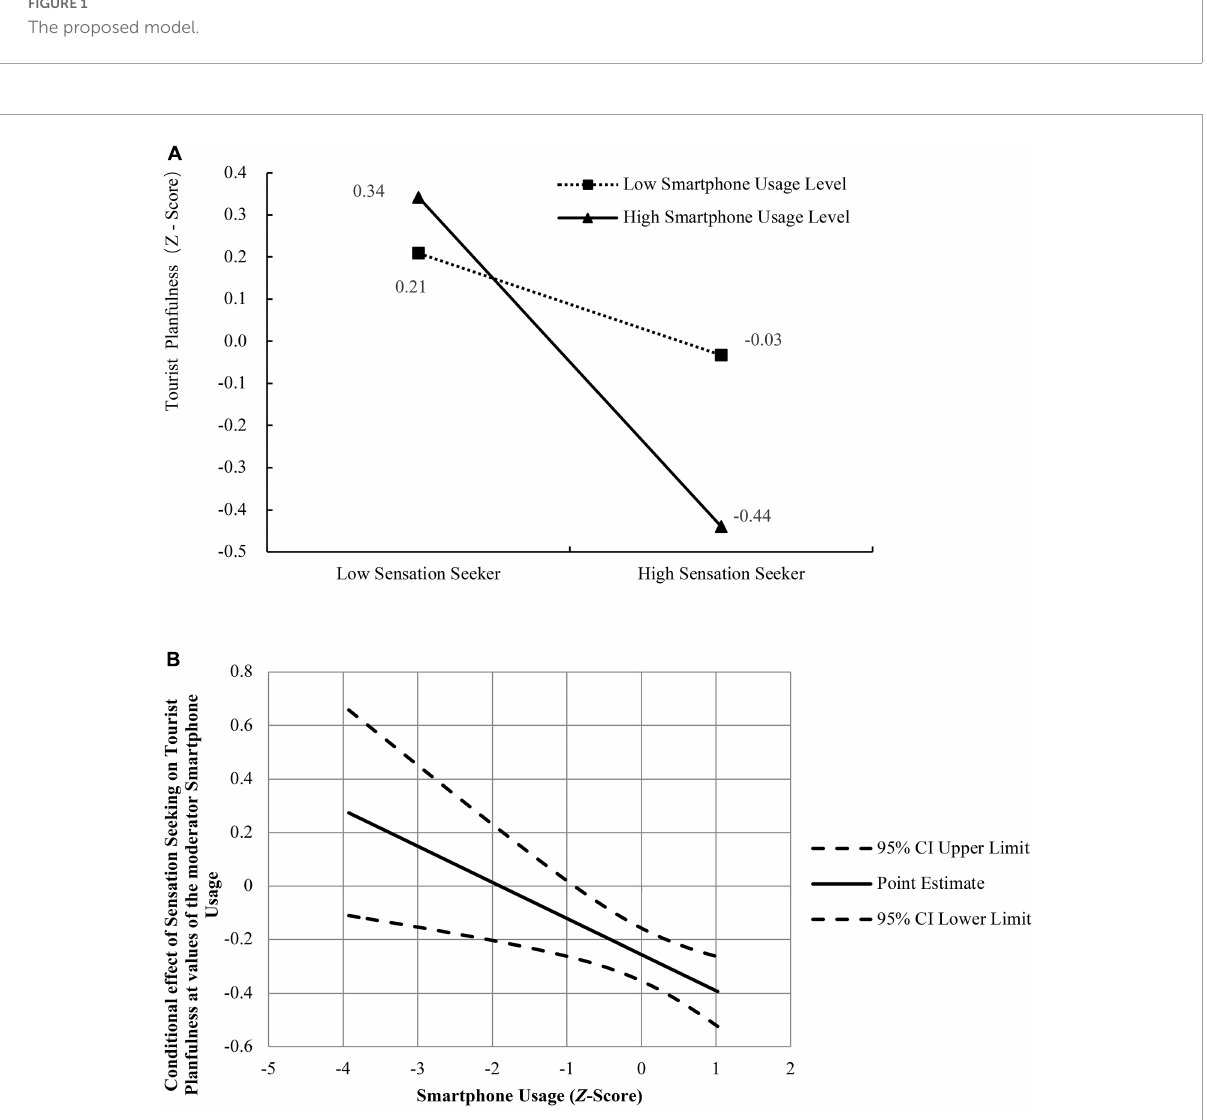
FIGURE2 (A) Plot of the relationship between sensation seeking and tourist planfulness at two levels of smartphone usage. (B) Graphing of the conditional effect of sensation seeking on tourist planfulness at values of the moderator smartphone